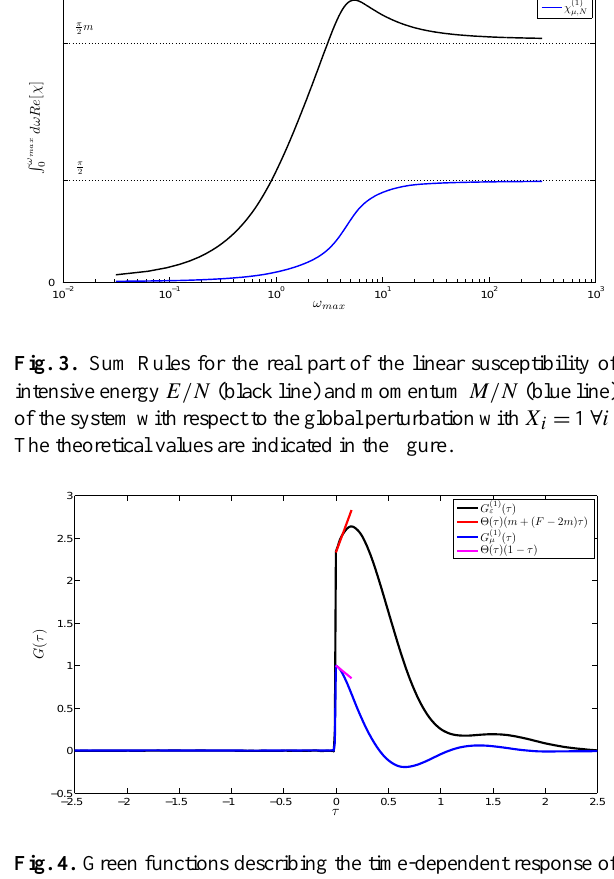
Fig. 4. Green functions describing the time-dependent response of the observable of intensive energy E/N (black line) and momentum M/N (blue line) with respect to the global perturbation with X i = 1 ∀ i . For both observables, the short time behavior of the Green function estimated from the asymptotic behavior of the corresponding susceptibility is shown in figure.